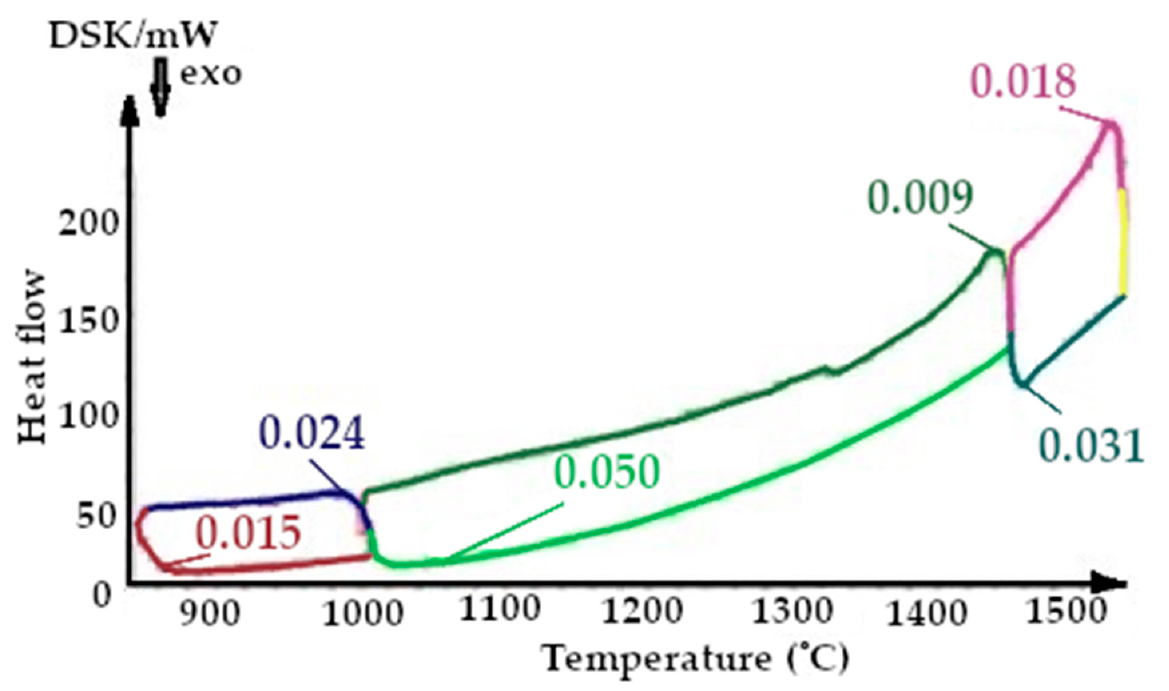
Figure 12. Fragment of the thermogram of quartzite, calcified at a temperature of 800 °C (Cycle 2),